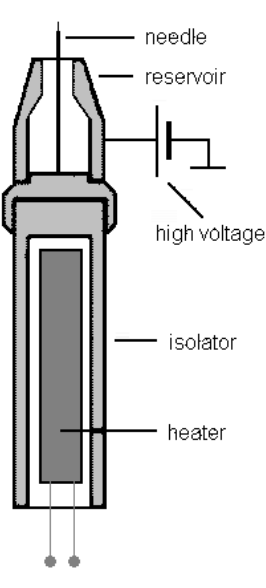
Fig. 2. Schematic of an emitter needle. The overall length of the assembly is